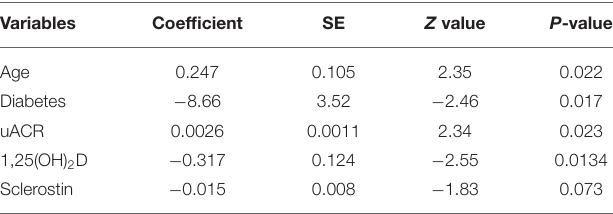
TABLE 2 | Multivariate regression model for predicting absolute PTH (1–84) increase at 6 months.